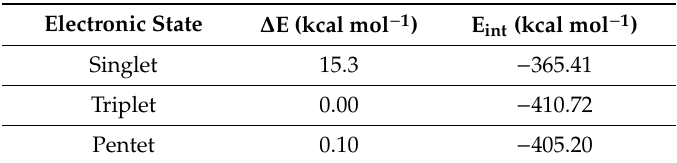
Table 4. Relative electronic energies ( ∆ E) and interaction energies (E int ) (in kcal mol − 1 ) for singlet, triplet, and pentet lowest electronic states of Compound 1.